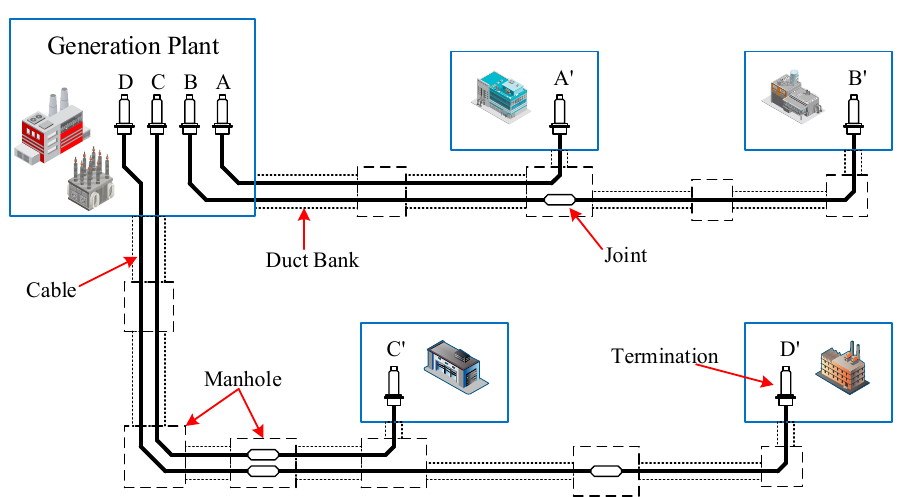
Figure 2. Simplified underground cable system and diagram of five major components.